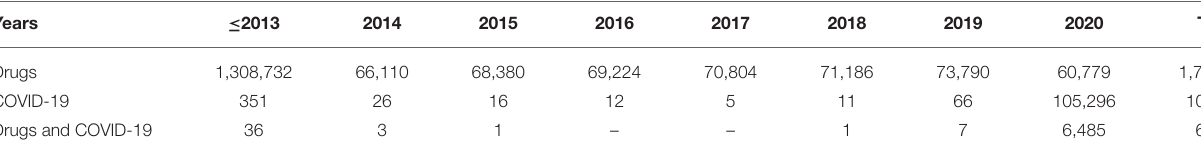
TABLE 2 | Most productive therapies and drugs. Production and impact. Drugs/therapies TSP Hydroxychloroquine Chloroquine Lopinavir Ritonavir Tocilizumab Convalescent plasma Azithromycin Monoclonal antibodies Angiotensin-converting enzyme 2